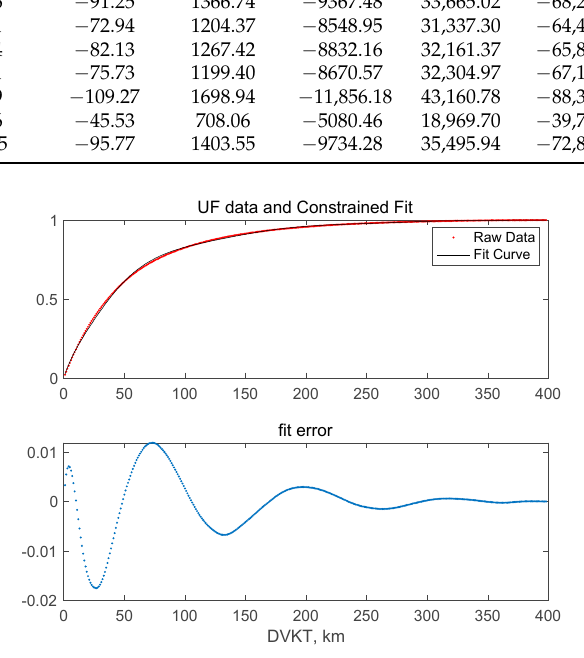
Table 6. Standard UF fitting parameters. Figure 5. UF fitting error illustration (Beijing).